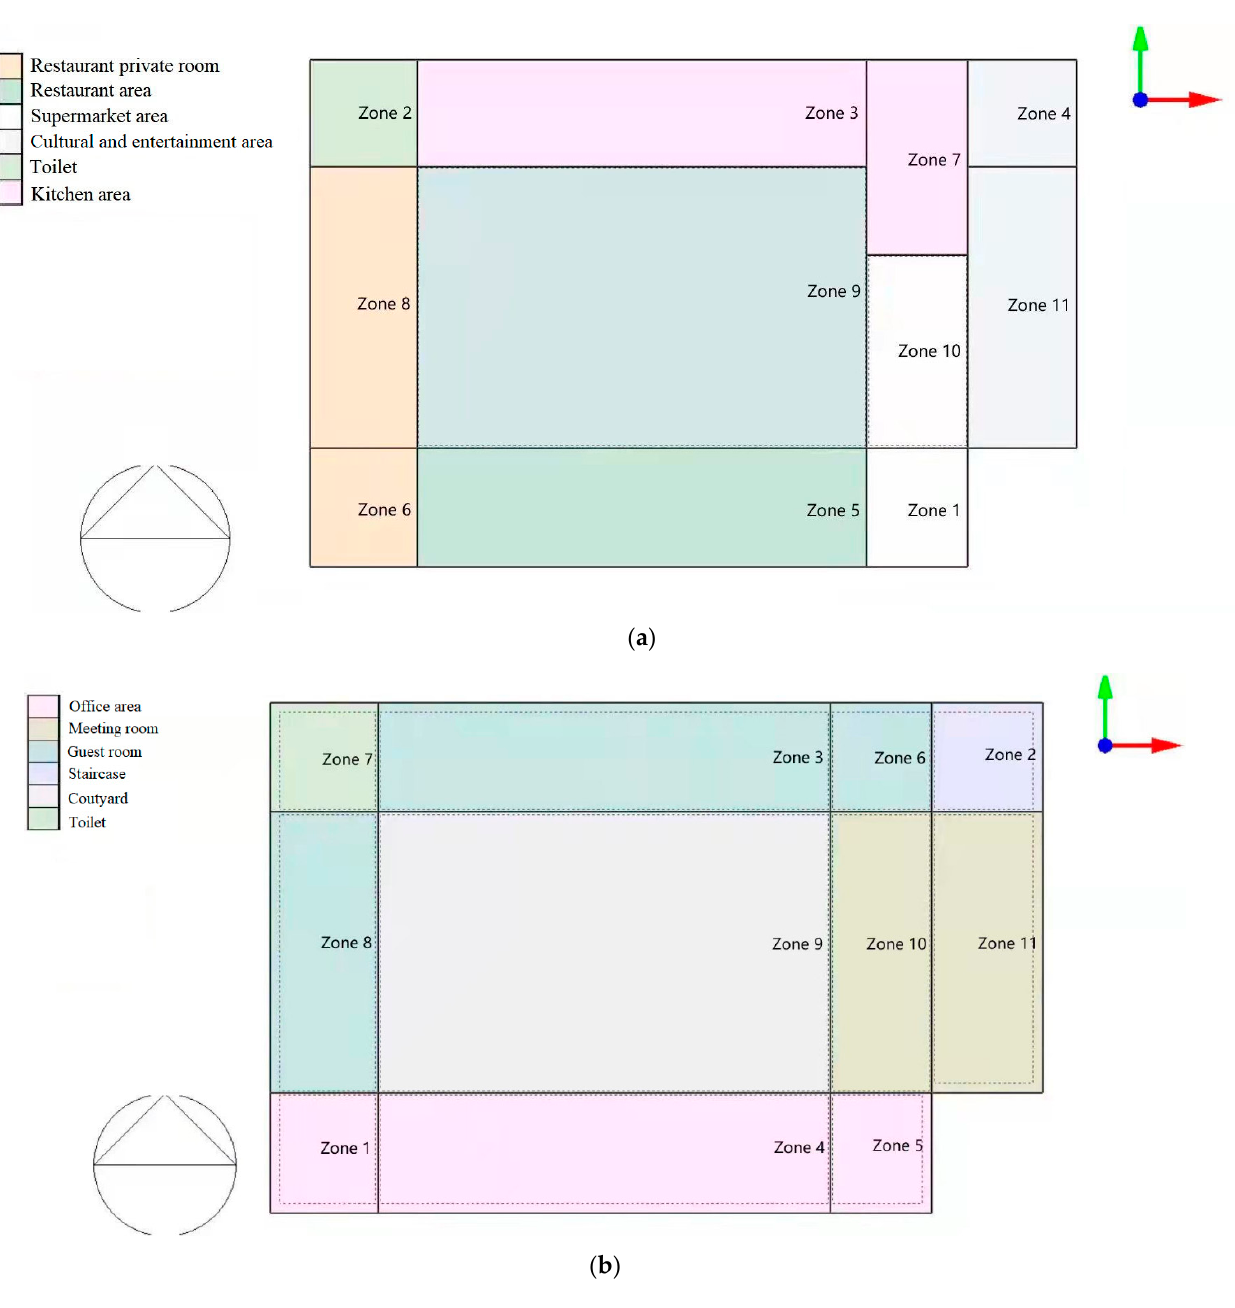
Figure 4. Typical highway service building DesignBuilder model.